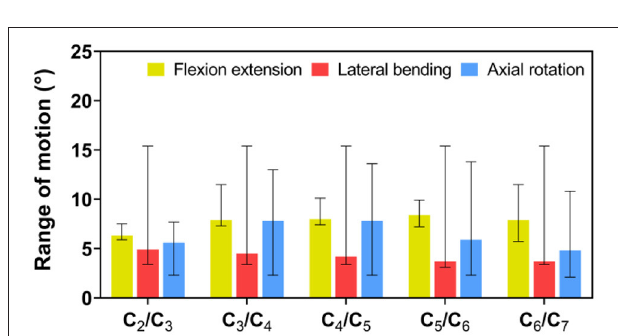
FIGURE 5 | Validation of intact finite element (FE) cervical spine model. Range of motion (ROM) outputs obtained from the intact FE model were compared with the literature data to assess the validity of the model. ROM at each segment in the intact FE model was entirely in the range of literature